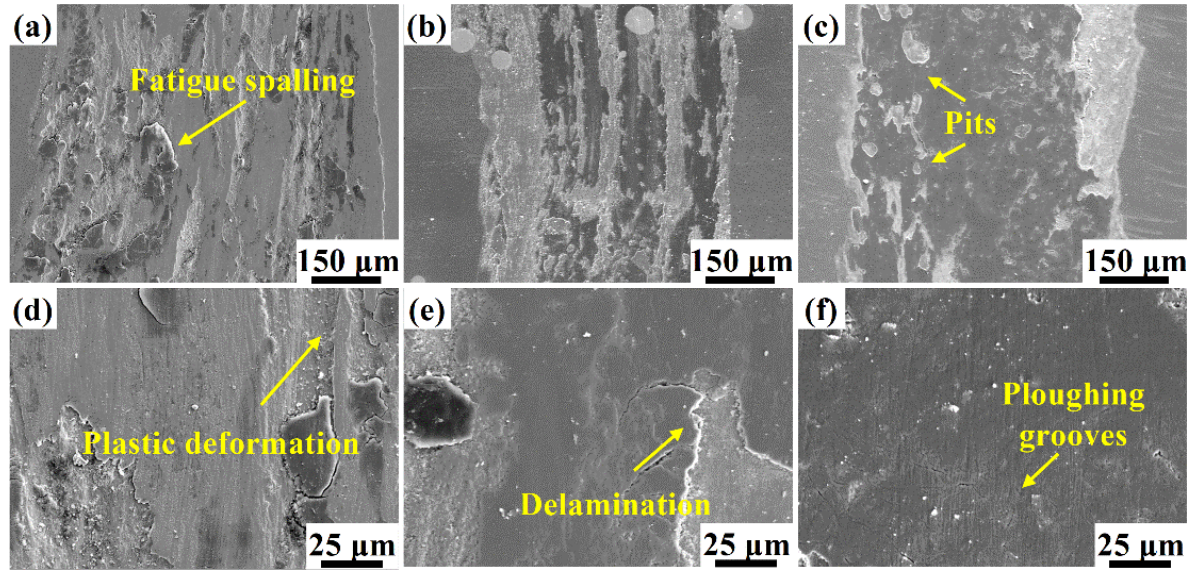
Figure 12. SEM morphologies of wear marks: ( a , d ) substrate, ( b , e ) coatings without vibration, and ( c , f ) coatings with